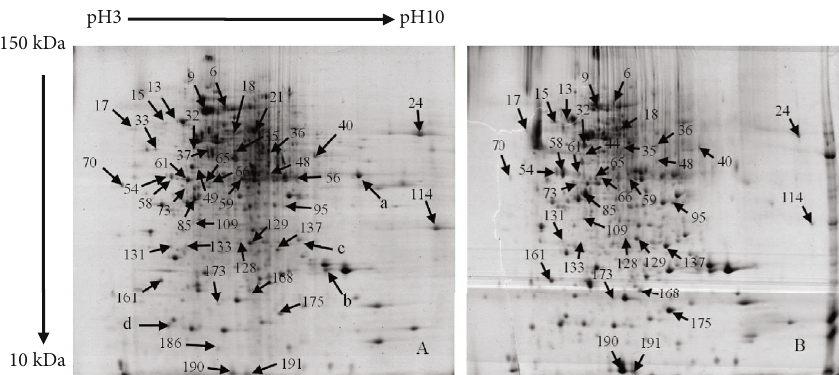
Figure 1: The two-dimensional electrophoresis gel diagram of Coriolus versicolor treated with methanol extracts of Cinnamomum camphora xylem. Table 1: Di ff erential expressed spots of Coriolus versicolor treated with methanol extracts identi fi ed by mass spectrometry. Spot